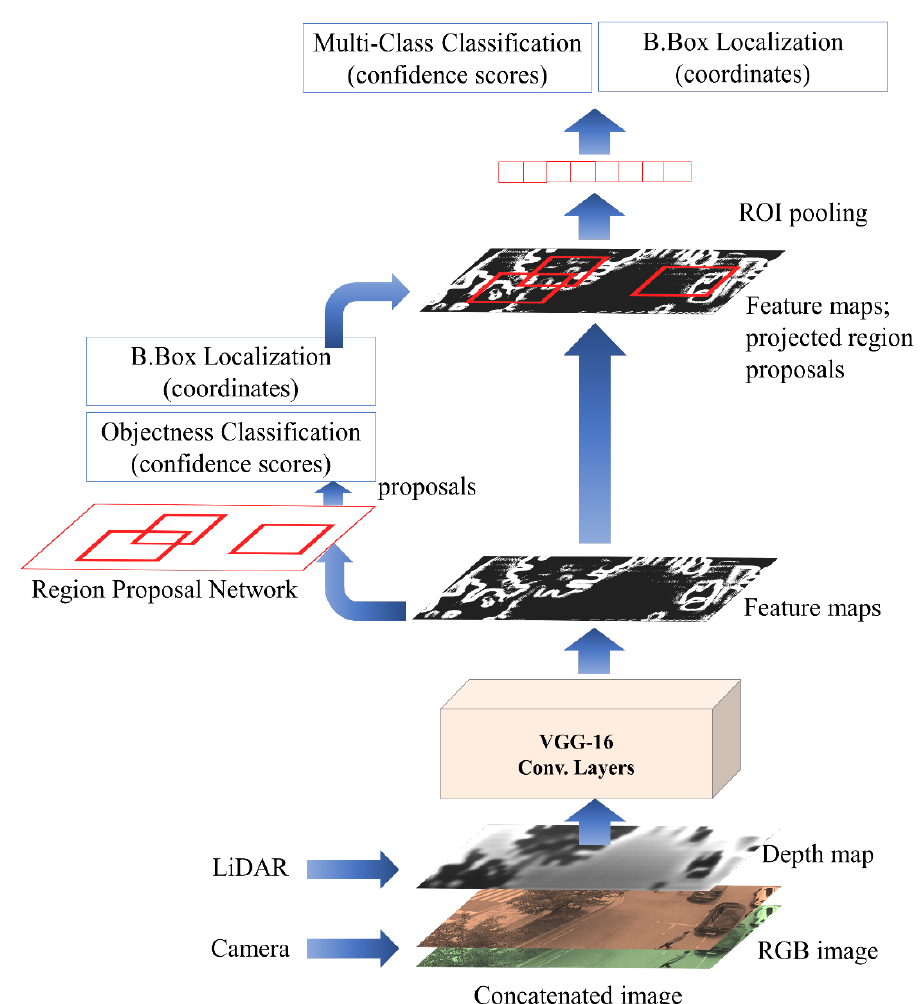
Figure 3. Faster region-based convolutional neural network (R-CNN) pipeline for object detection by integration of a camera and light detection and ranging (LiDAR).